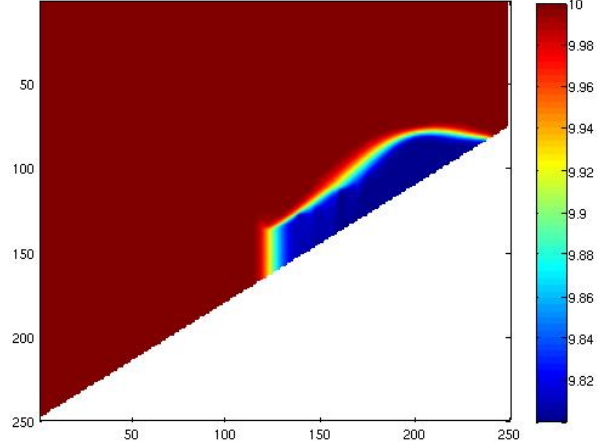
Fig. 6. Along-slope transport of the gravity current (normalised by the initial geostrophic value) in the 2.5-D experiments during the first 7 days of the